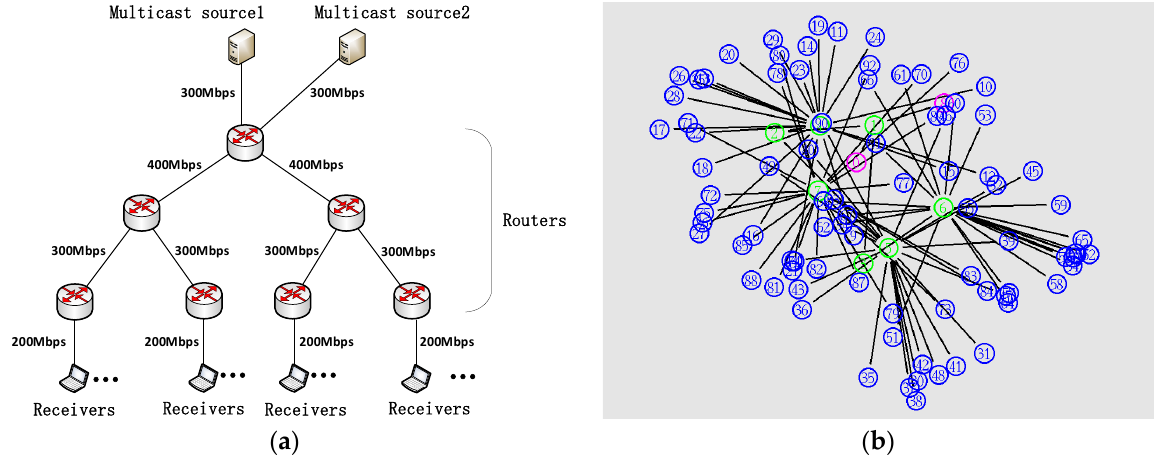
Figure 5. The simulation topology. ( a ) The multicast tree structure and the bandwidths of links in simulation topology. ( b ) The simulation topology with 80 receivers for GUMSID1 and 4 receivers for GUMSID2 in NS-2.